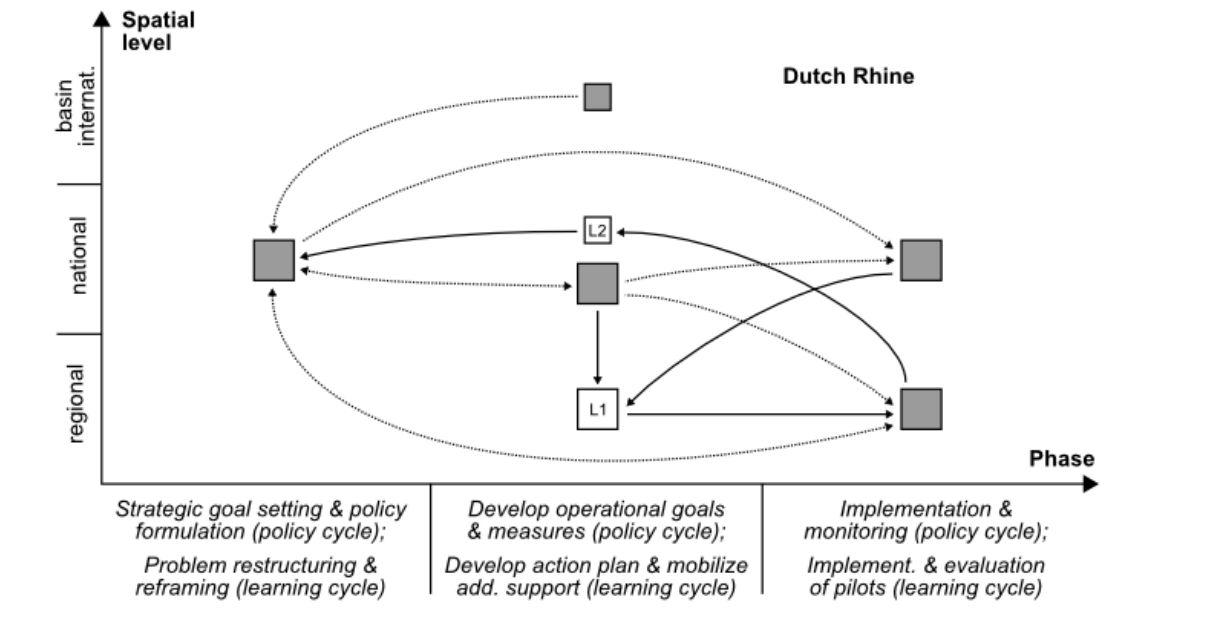
Fig. 4 . Formal policy and informal learning processes and their interdependencies in the Dutch Rhine. See Figure 2 for detailed explanations of the notations and Figure A2 in Appendix 1 for the nonaggregated